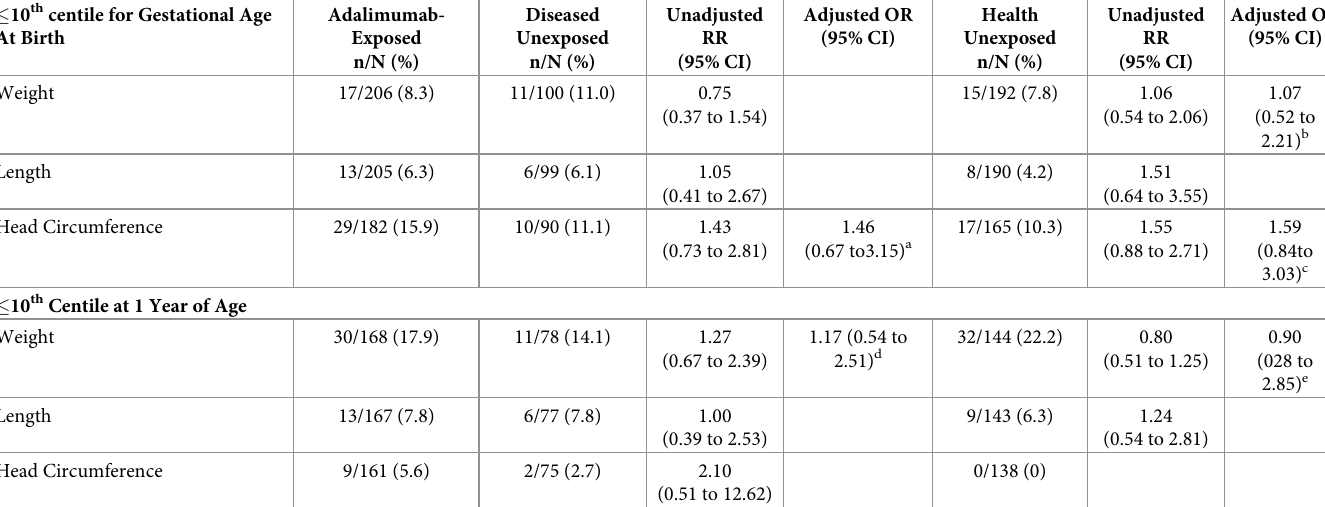
Table 5. Pre- and postnatal growth deficiency in singleton infants born to women exposed to adalimumab compared to unexposed, 2004 to